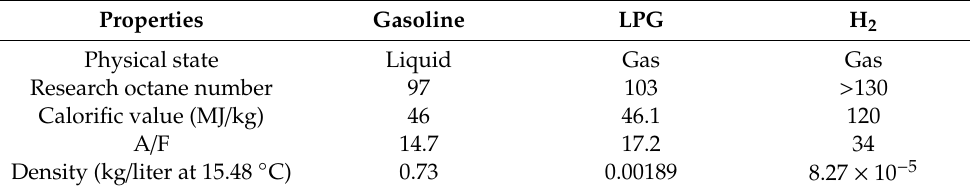
Figure 1. Schematic of experimental set-up. Table 1. Test fuels properties a employed in